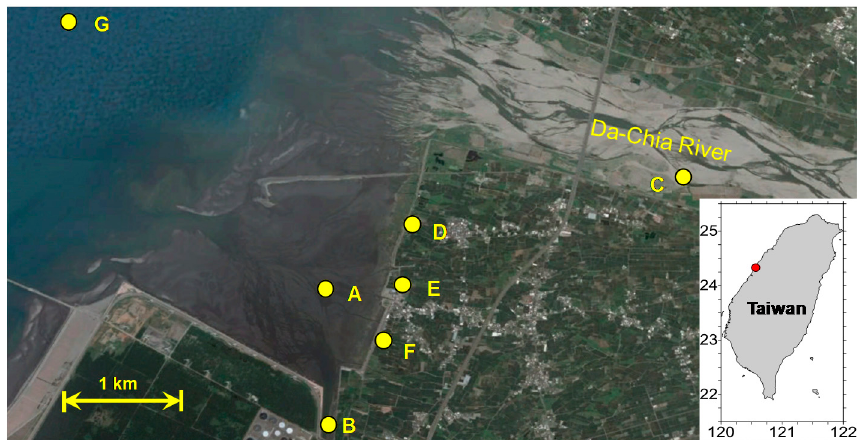
Figure 1. The map of the Gaomei Wetland with all sampling locations. A is the time-series station. D, E, and F show the sites of the artesian wells around the Gaomei Wetland where the groundwater samples were taken. B (the outlet of Qingshui drainage) and C (the estuary of Da-Chia River) are the locations where the fluvial waters were sampled as landward sources; whereas at station G, an offshore seawater sample was taken as a seaward source (adapted from Google Earth).